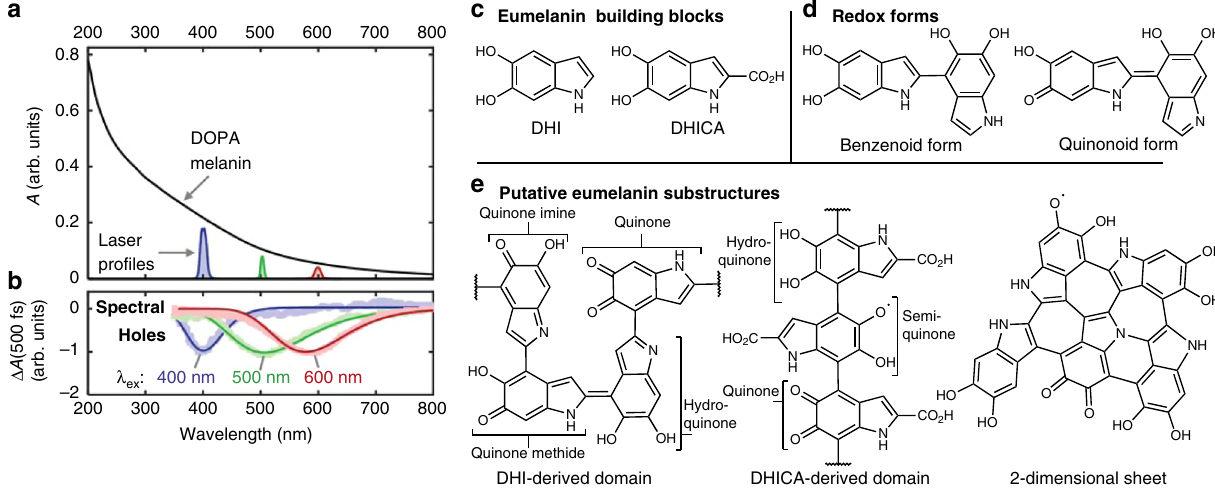
Fig. 1 Transient spectral hole burning of DOPA melanin (eumelanin) and putative chromophore structures. a Absorption spectrum (black curve) of an aqueous solution of DOPA melanin. Pro fi les of excitation laser pulses (colored curves) used in femtosecond transient absorption measurements showing their spectral width (arbitrary vertical scaling). b Transient spectral holes extracted from transient absorption spectra measured 500 fs after excitation at 400, 500, or 600 nm. c Chemical structures of eumelanin building blocks. d Dimers of the building blocks, showing two major types of redox forms. e A few substructures proposed for DOPA melanin and other eumelanins. Labels indicate redox forms, which vary from least to most oxidized in the order hydroquinone<semiquinone<quinone